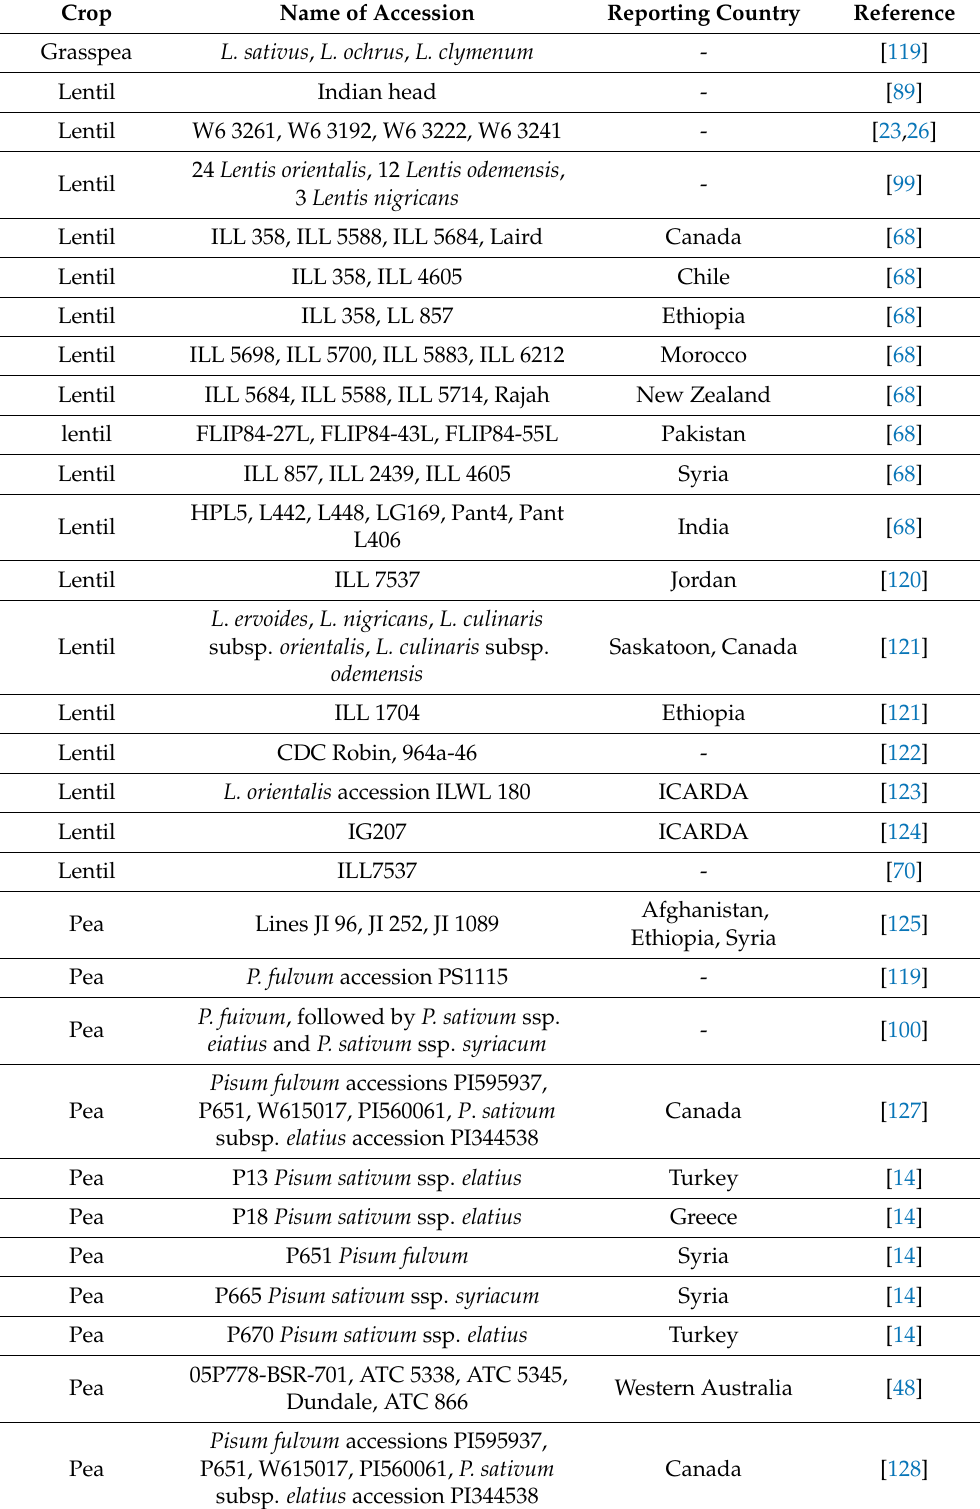
Table 2. Cont. Crop Name of